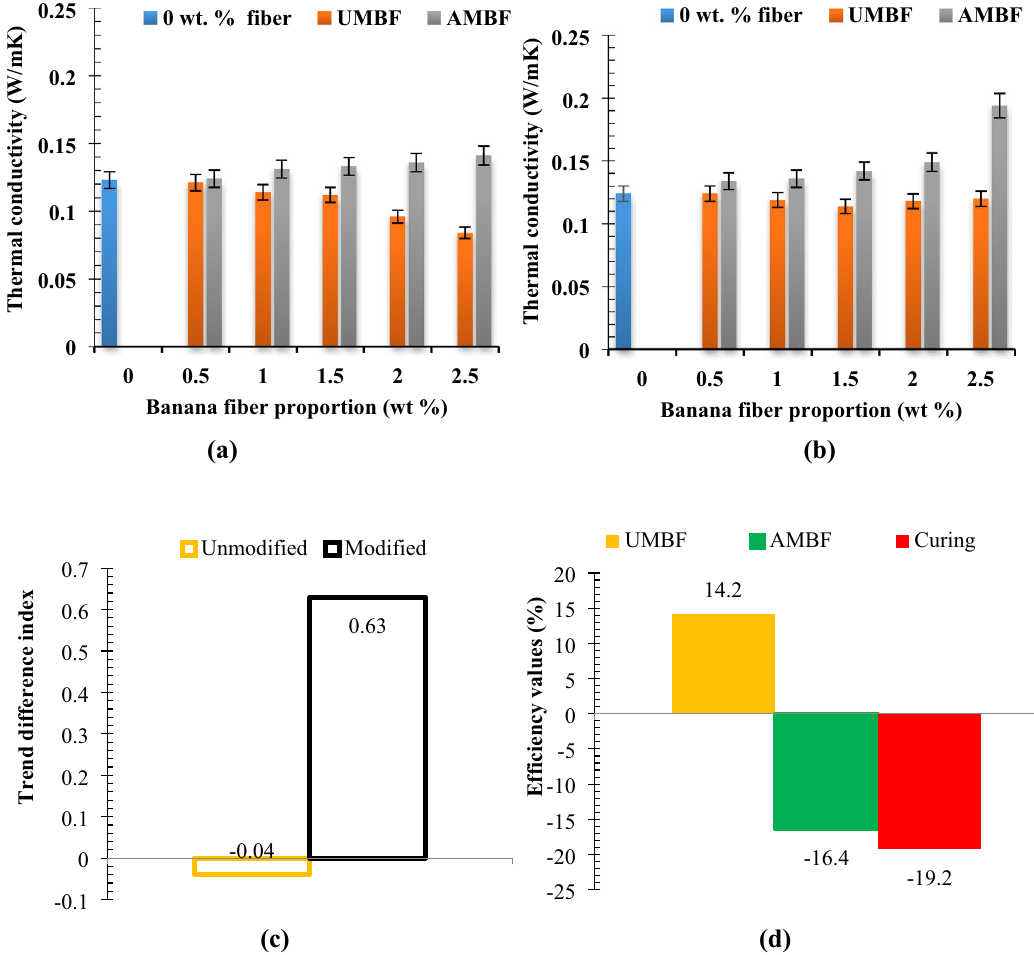
Figure 9. Relation between fiber proportion of unmodified and modified fiber on thermal conductivity at curing days of ( a ) 28 days and ( b ) 56 days with ( c ) experimental trend analysis and ( d ) property evaluation of experimental